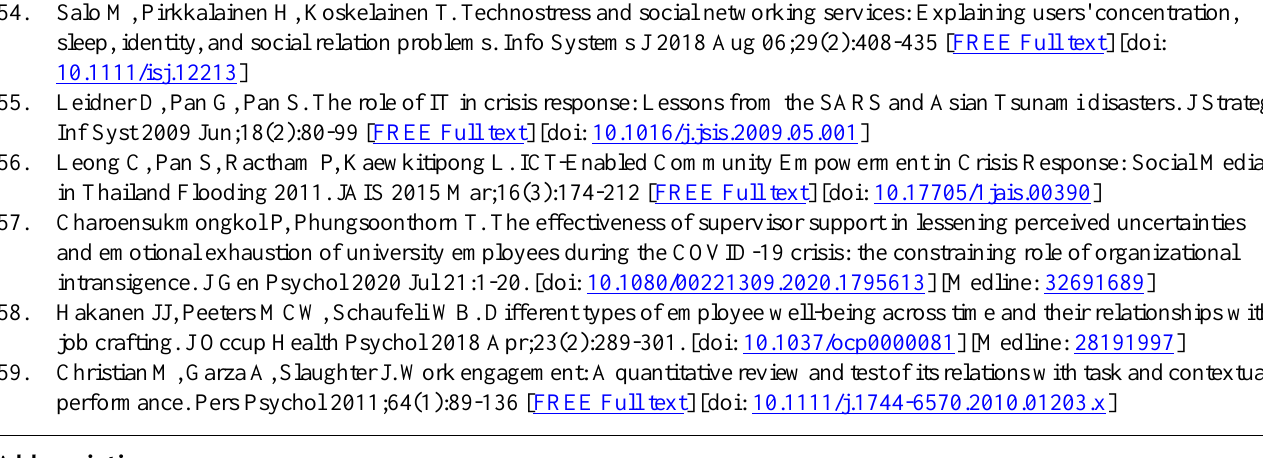
Abbreviations COR: Conservation of Resources UWES: Utrecht Work Engagement Scale